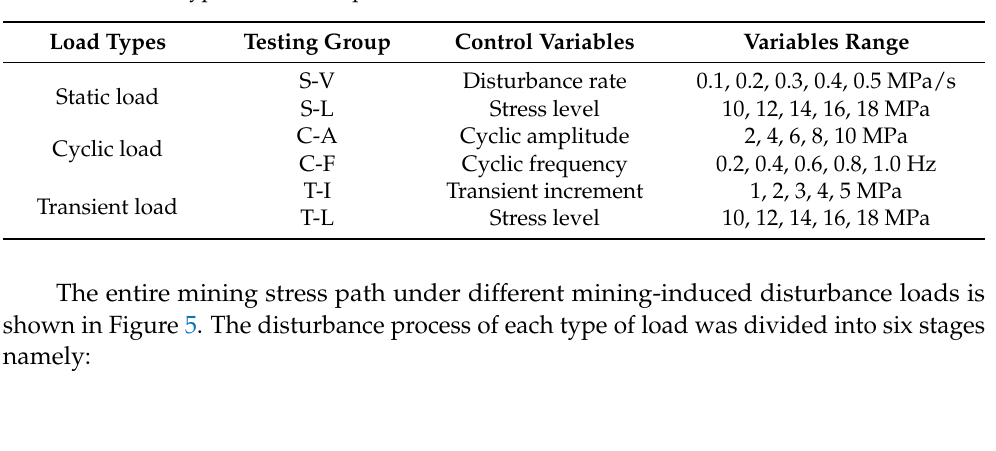
Table 1. Different types of coal samples and their numbers.